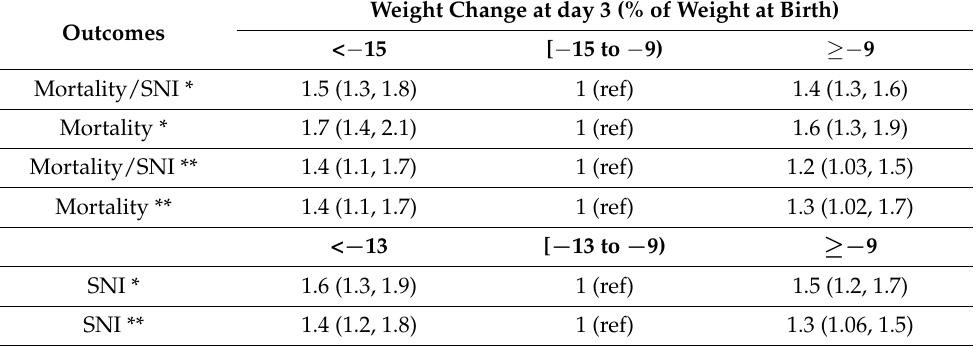
Table 6. Comparisons of outcomes depending on weight change (% of birth weight) at day three of